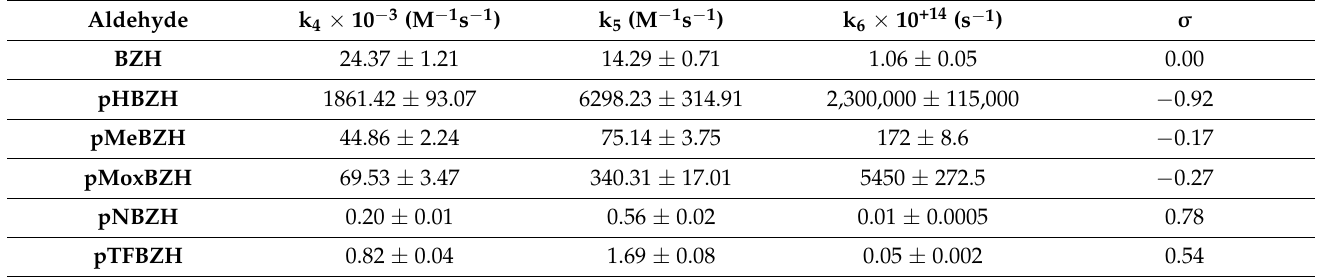
Table 5. Reaction constants for the aldehydes studied, together with the bibliographic values obtained for the parameter σ